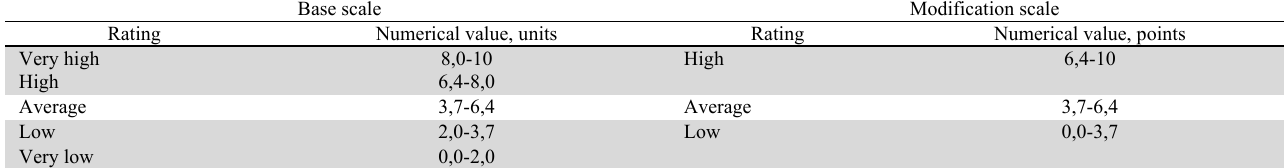
Fig. 2. Assessing the impact of outsourcing on the performance of an industrial enterprise Table 1 The scale for translating the coefficients of the ratio of costs of the business process to the average cost in